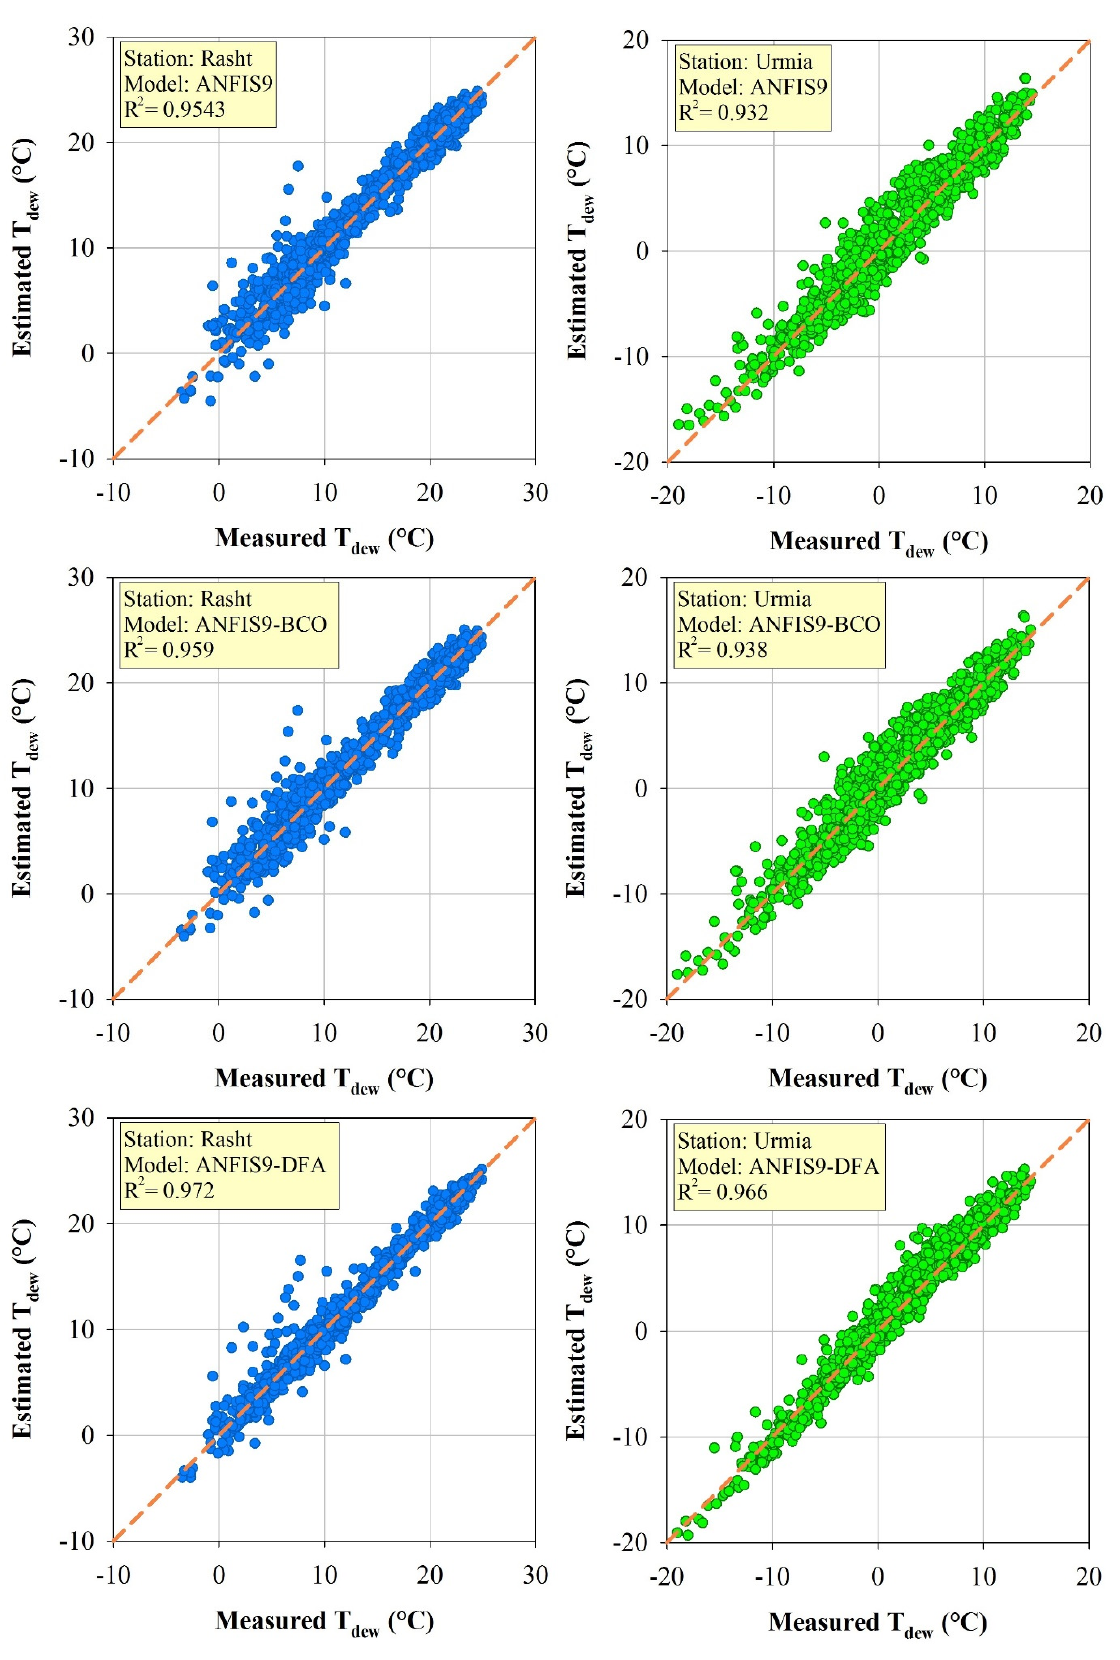
Figure 5. Scatter graphs of the measured and estimated Tdew through the best-performing classical and hybrid models at the studied stations during the testing period.